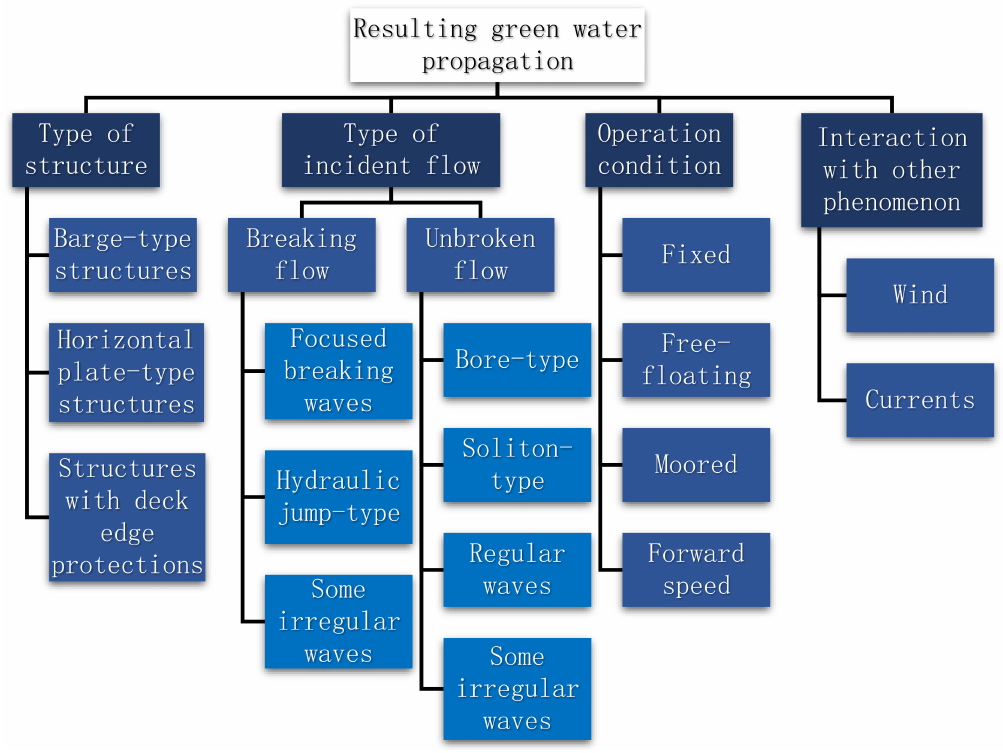
Figure 15. Factors that can influence green water